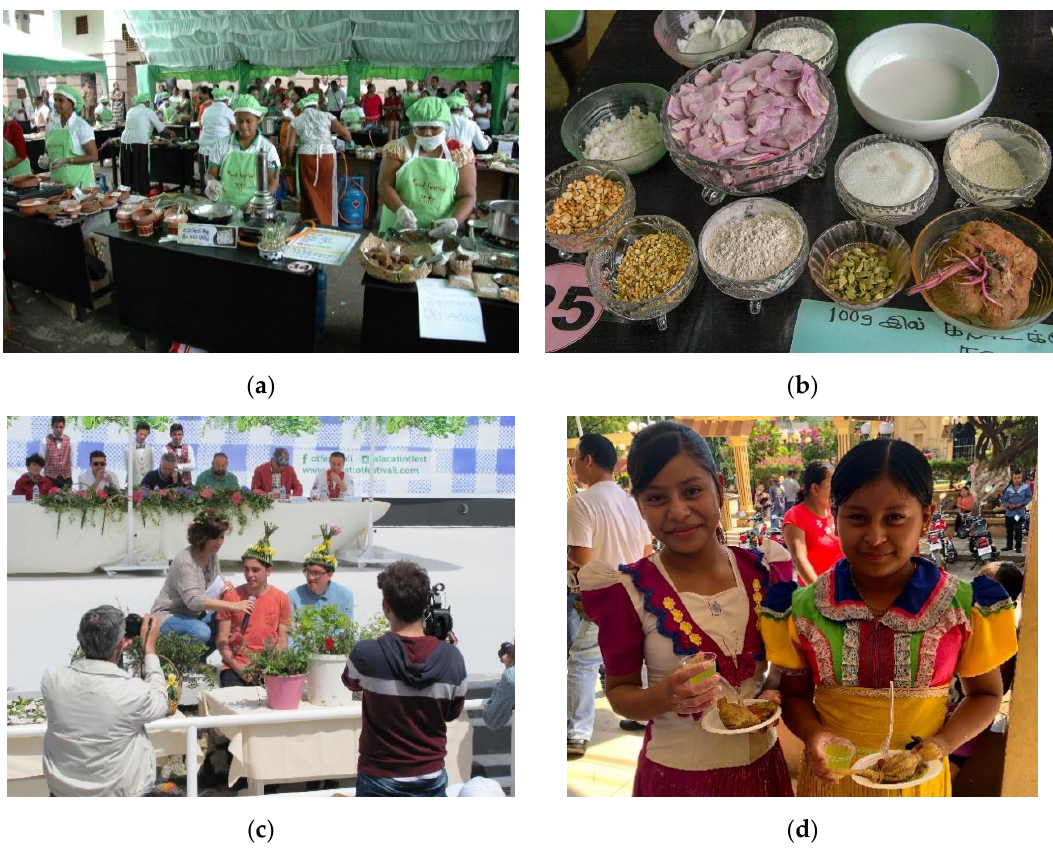
Figure 5. Festivals and gastronomy events help raise the profile of orphan crops in the intervention countries. ( a ) Food festival celebrating orphan crops and fruits carried out in Peradeniya, Sri Lanka for World Food Day. Credit: Bioversity International/D. Hunter. ( b ) Local yam is the main ingredient of a competition recipe at the Food Festival. Credit: Bioversity International/D. Hunter. ( c ) The young winners of the wild herb collection competition held during the Alaçatı Wild Herb Festival are interviewed by national television. Credit: Bioversity International / D. Hunter. ( d ) Chaya recipes promoted in Chiquimula Market, Guatemala. Credit: Bioversity International / N. Amaya.